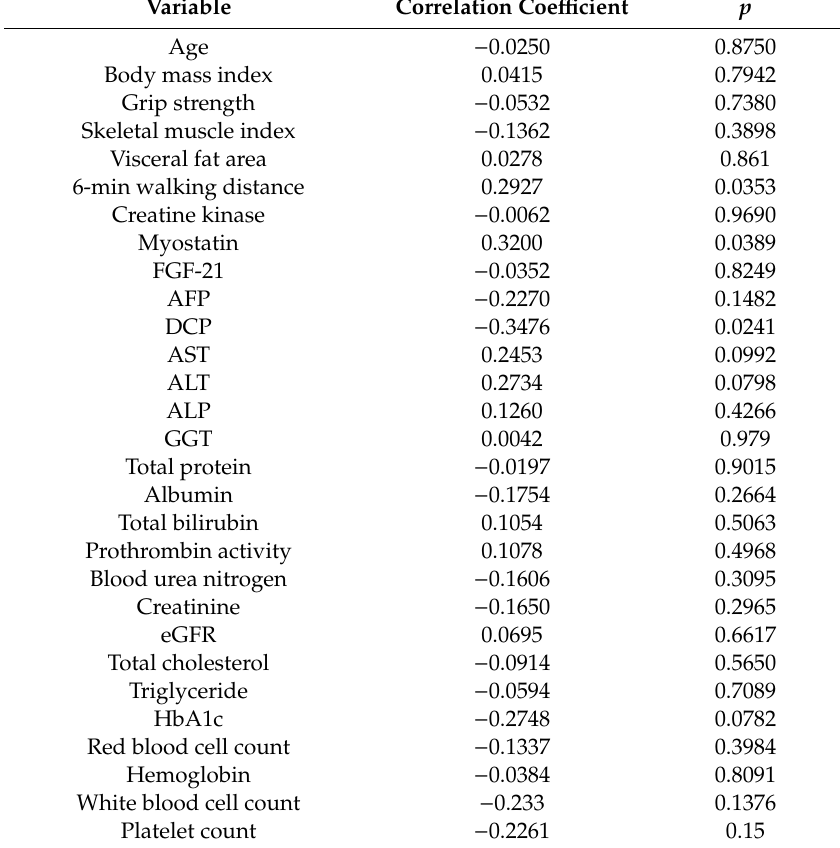
Table 2. Multivariate correlation analysis between serum decorin levels and each variable.